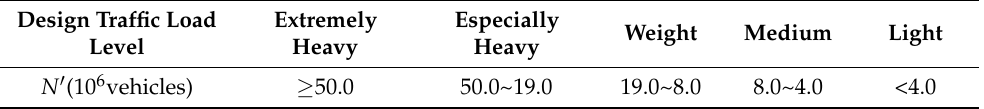
Table 1. Design traffic load